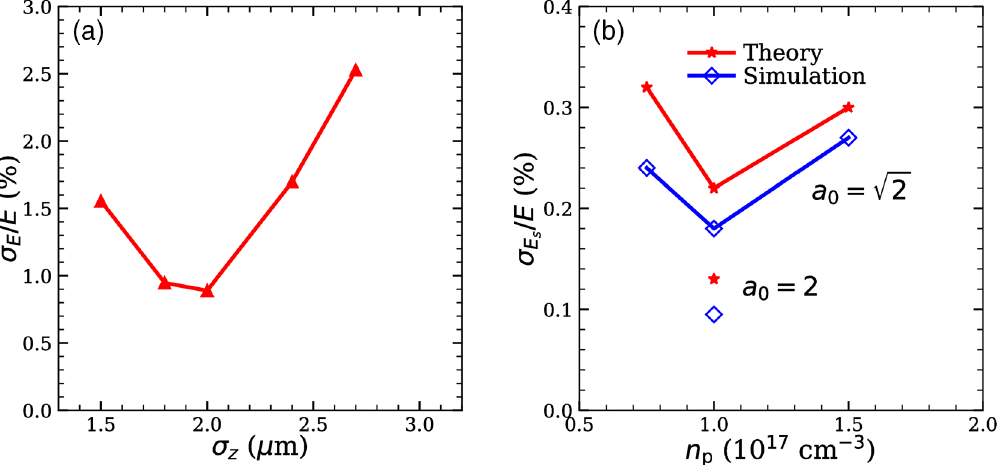
FIG. 7. (a) Minimization of energy spread with the bunch length. (b) Minimization of slice energy spread with the laser strength and the plasma density